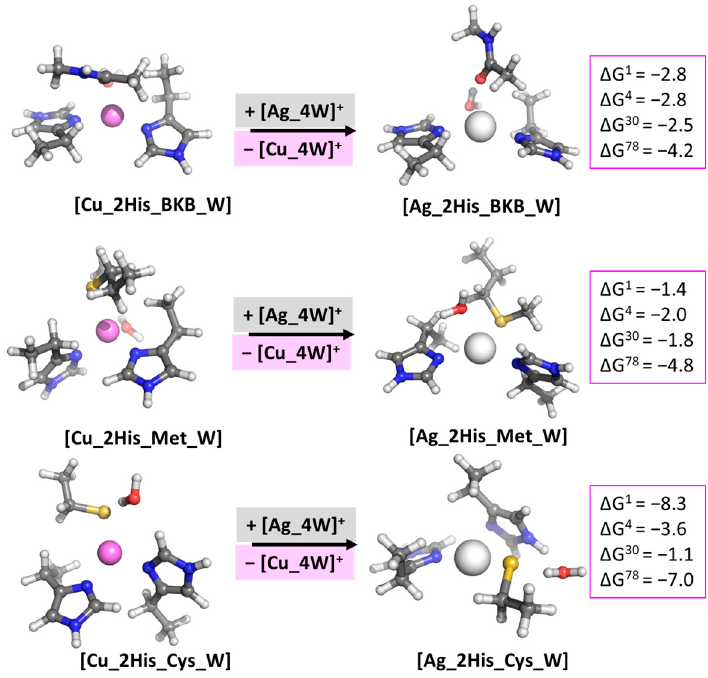
Figure 5. Gibbs energies of Ag + → Cu + substitution given in kcal.mol − 1 in four different environments (denoted as ∆ G 1/4/30/78 ) for M062X/6-311++G(d,p)/SDD-optimized [M_2His_AAM_W] structures. The applied color scheme has been previously presented in Figure 3.